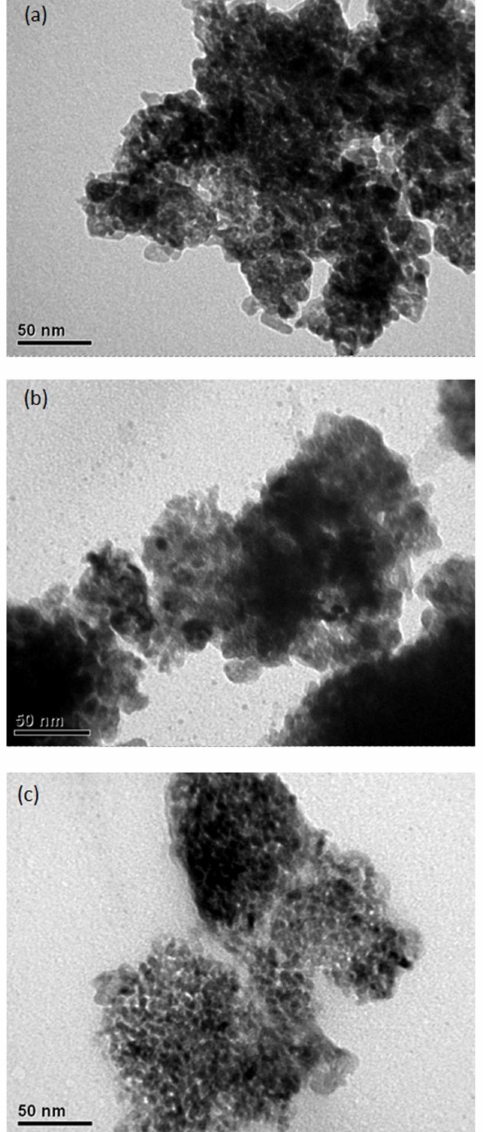
Figure 2. TEM images of the copper nanoparticles/ZrO 2 catalysts. ( a ) Cu NPs/ZrO 2 pH = 4, ( b ) Cu NPs/ZrO 2 pH = 7, ( c ) Cu NPs/ZrO 2 pH =